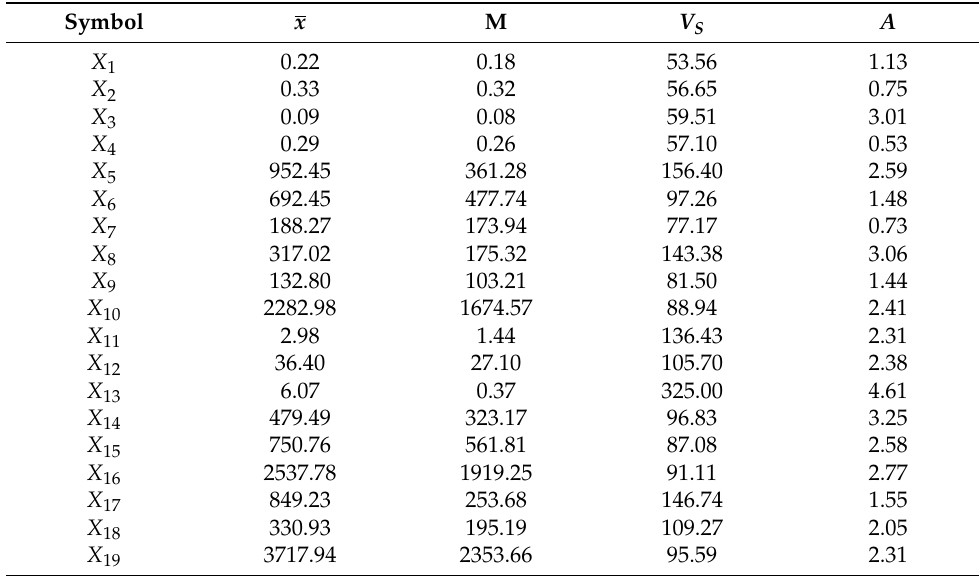
Table 2. Selected descriptive parameters for diagnostic